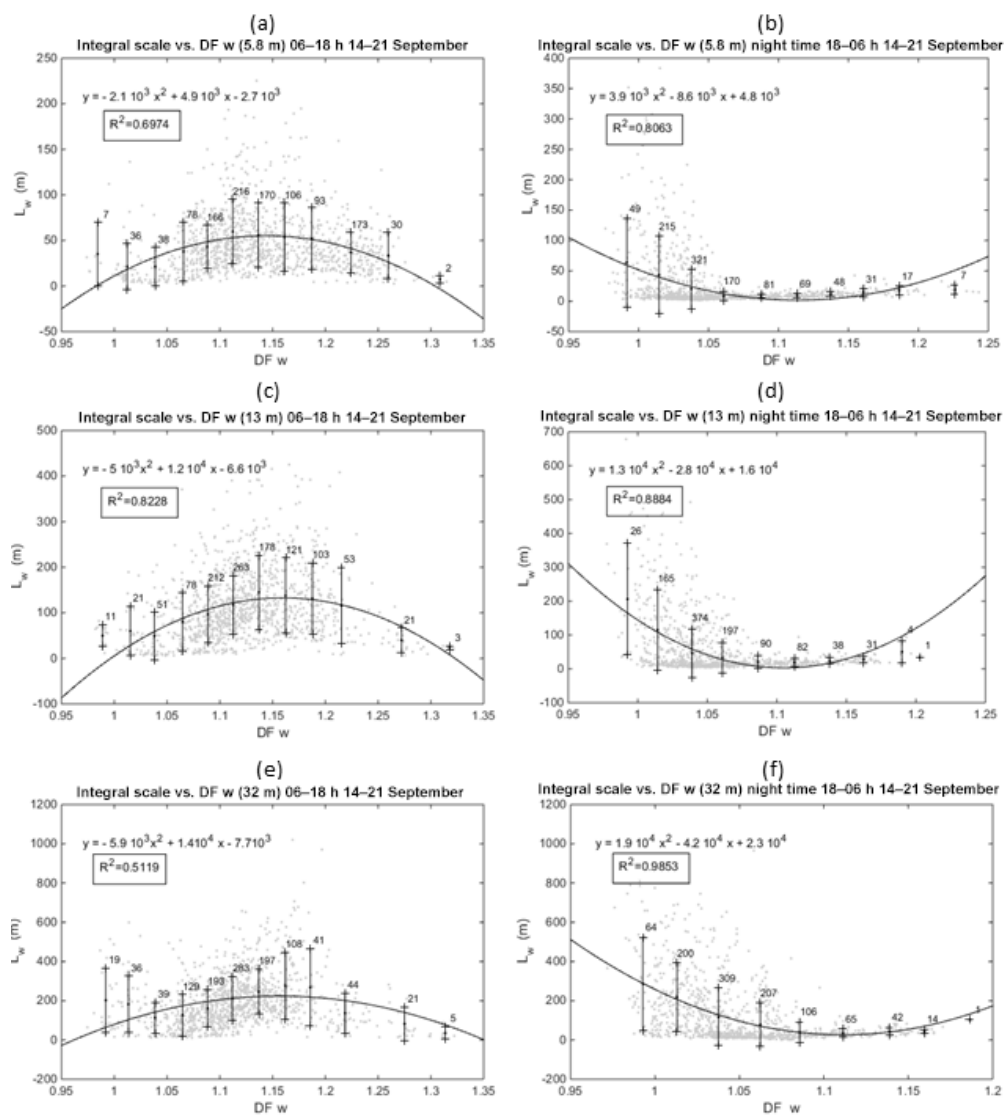
Figure 7. Variations of the integral scale vs. the fractal dimension of the w (cid:48) component at 5.8, 13 and 32m. (a) , (c) and (e) diurnal hours; (b) , (d) and (f) night hours. The fits to a quadratic function of the average values appear on the top left of each graph: y variable L intw and x variable DF w